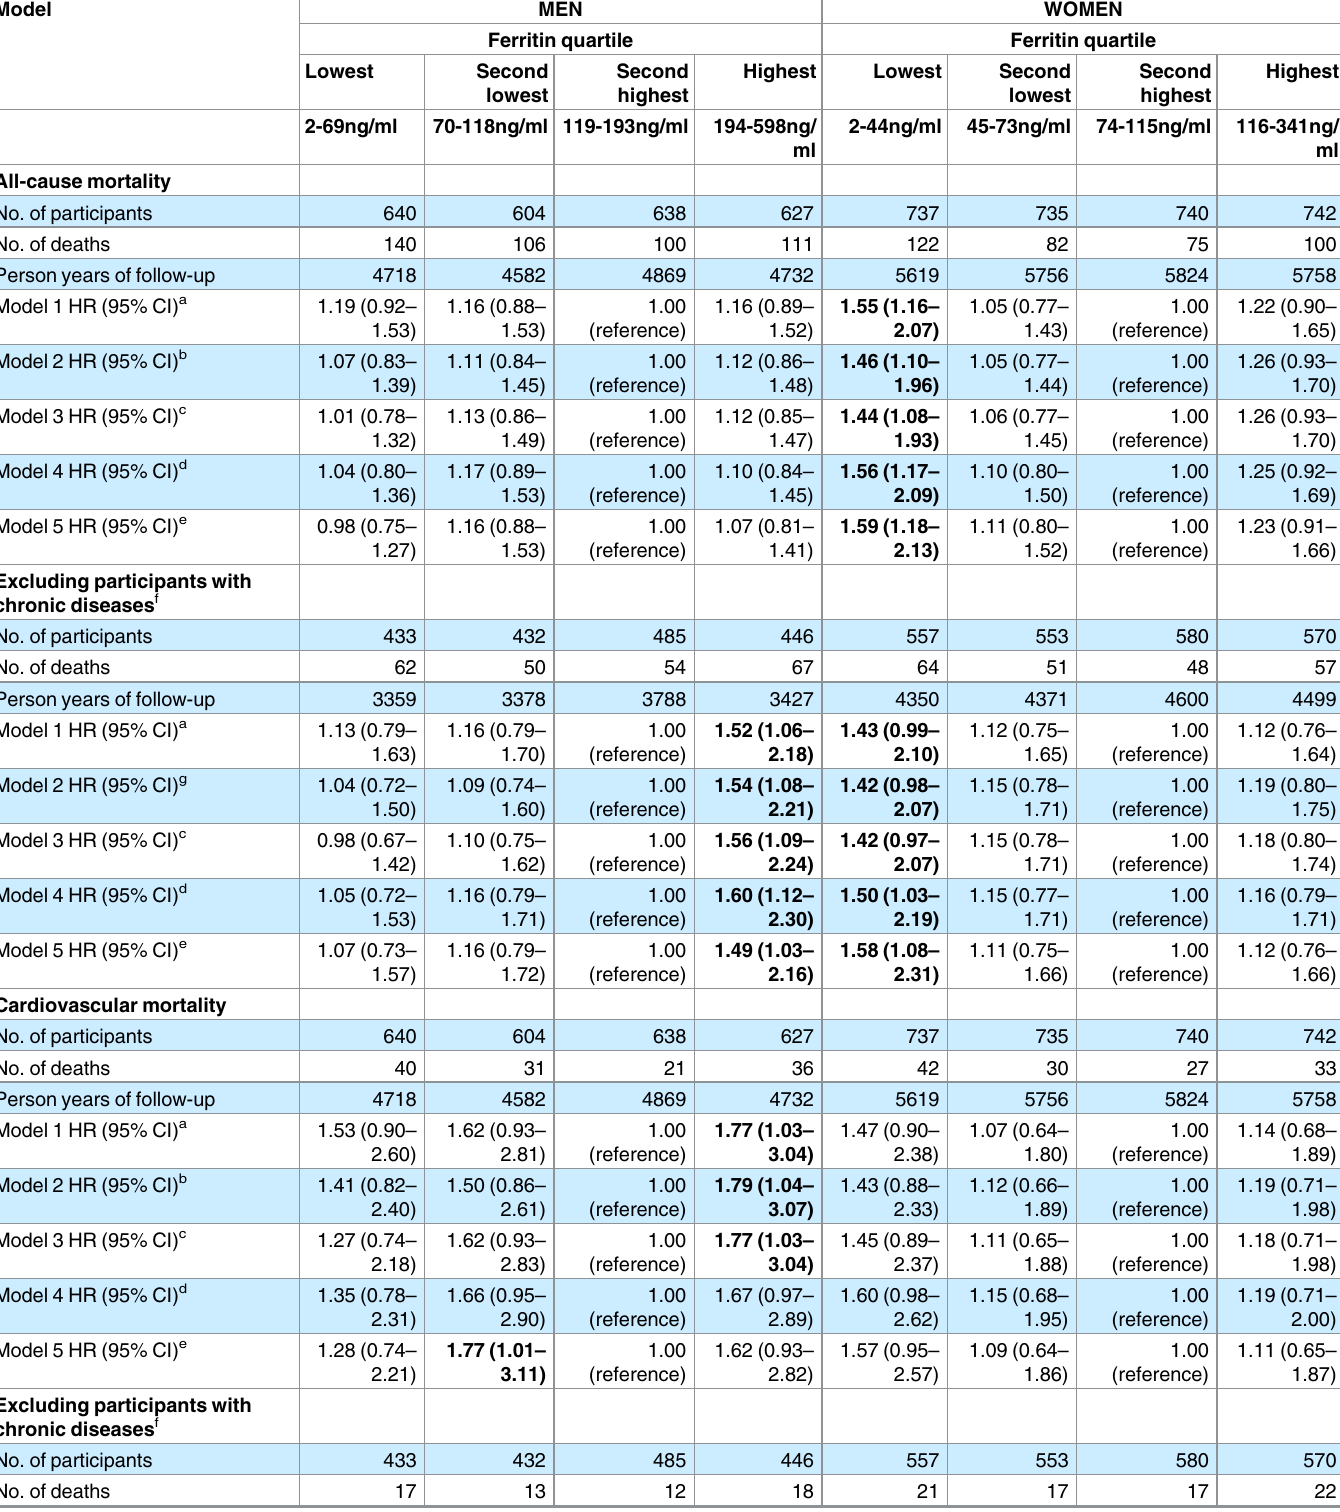
Table 2. Association between ferritin and all-cause and cardiovascularmortality by